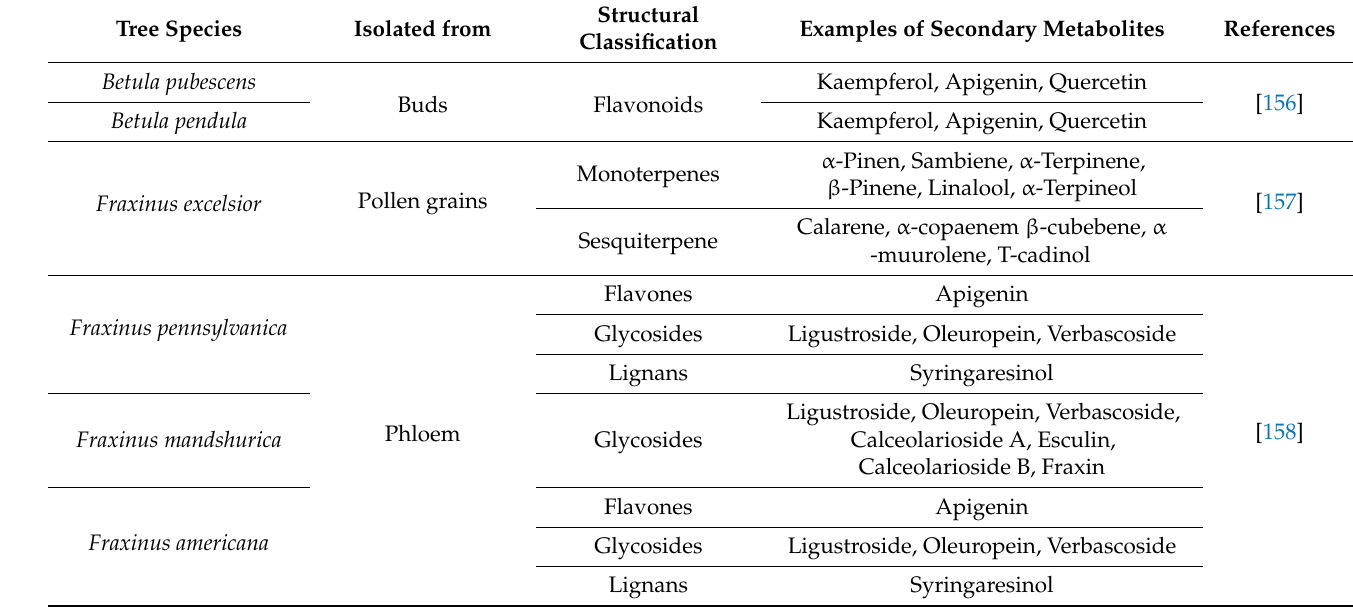
Table 2. Secondary metabolites produced by angiosperm tree